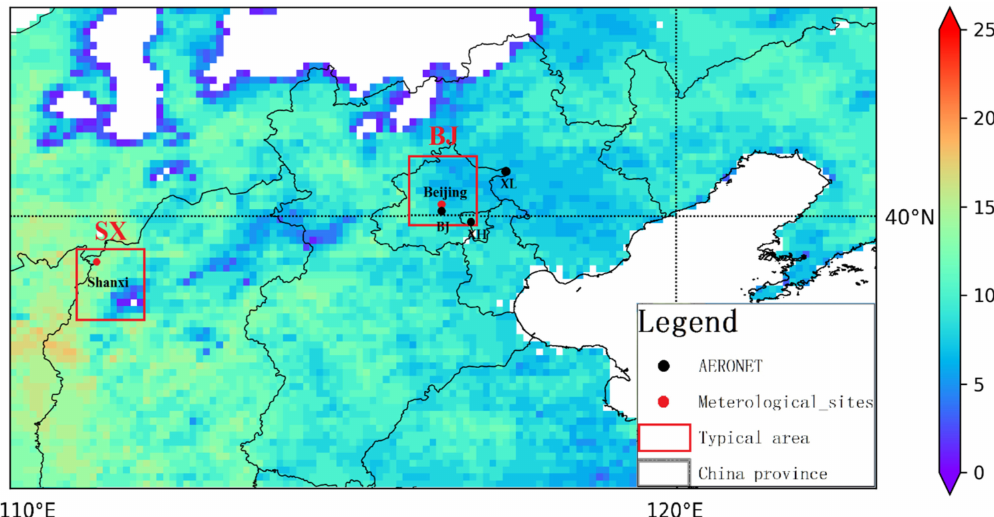
Figure 1. Number of pixels in 0.1 ◦ × 0.1 ◦ resolution observed by POLDER/PARASOL satellite over the North China Plain in January 2012. (Black points represent the AERONET sites (Beijing, Xianghe and Xinglong); red points represent the meteorological stations (Beijing and Shanxi); red square frames show the two selected regions BJ and SX,